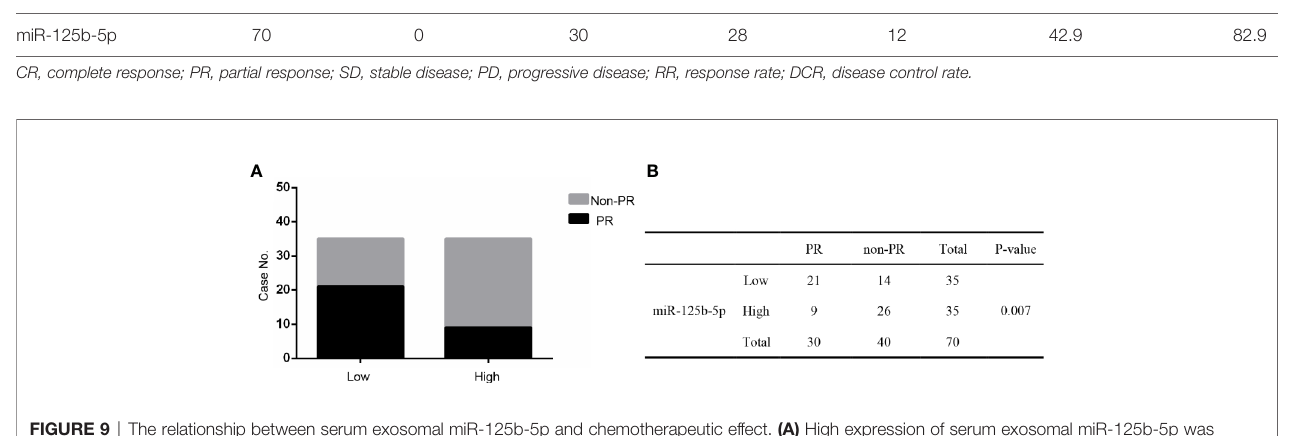
FIGURE 9 | The relationship between serum exosomal miR-125b-5p and chemotherapeutic effect. (A) High expression of serum exosomal miR-125b-5p was correlated with favorable fi rst chemotherapy response. (B) Response to the 1ST treatment in